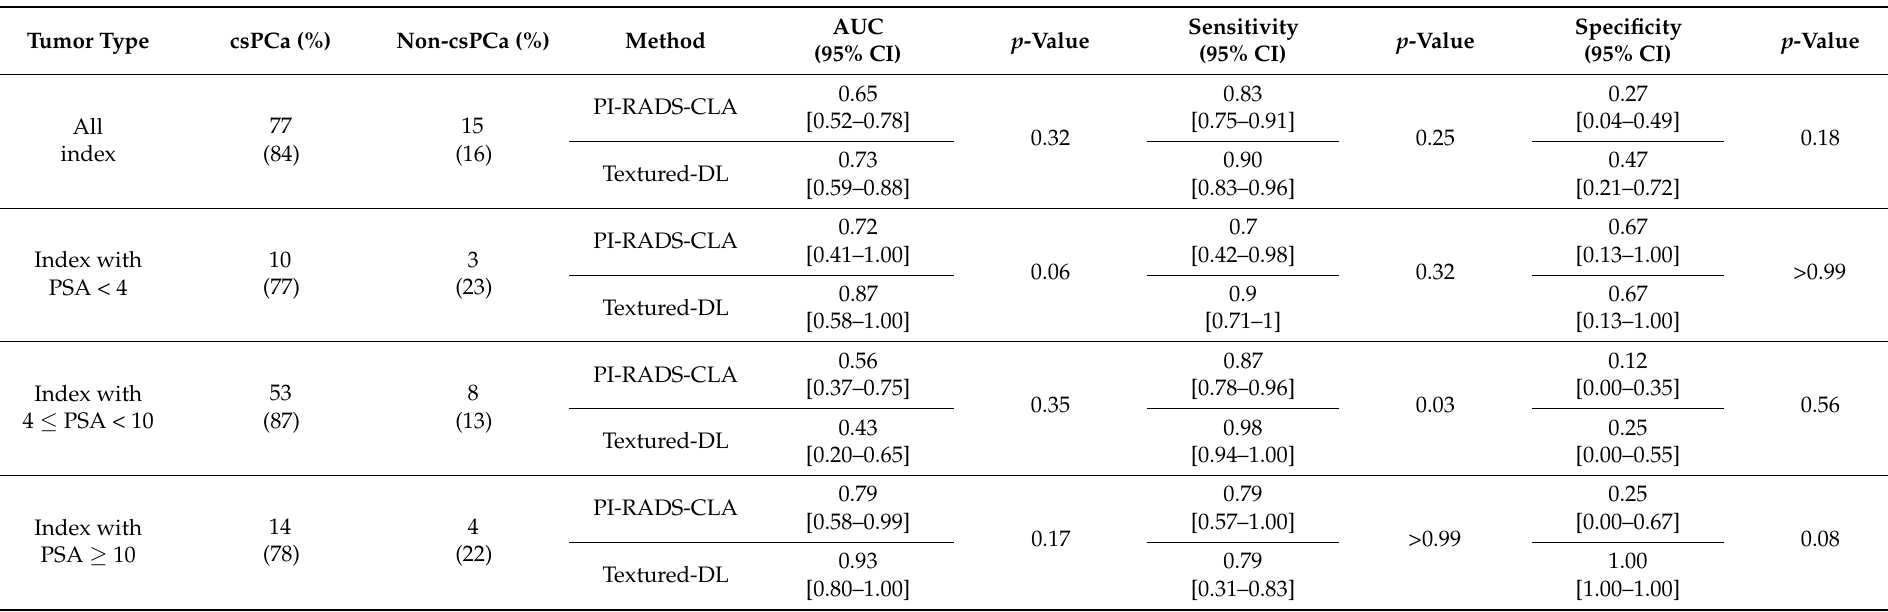
Table 3. Performance comparison between PI-RADS-CLA and Textured-DL on the classification of the index tumors with different PSA